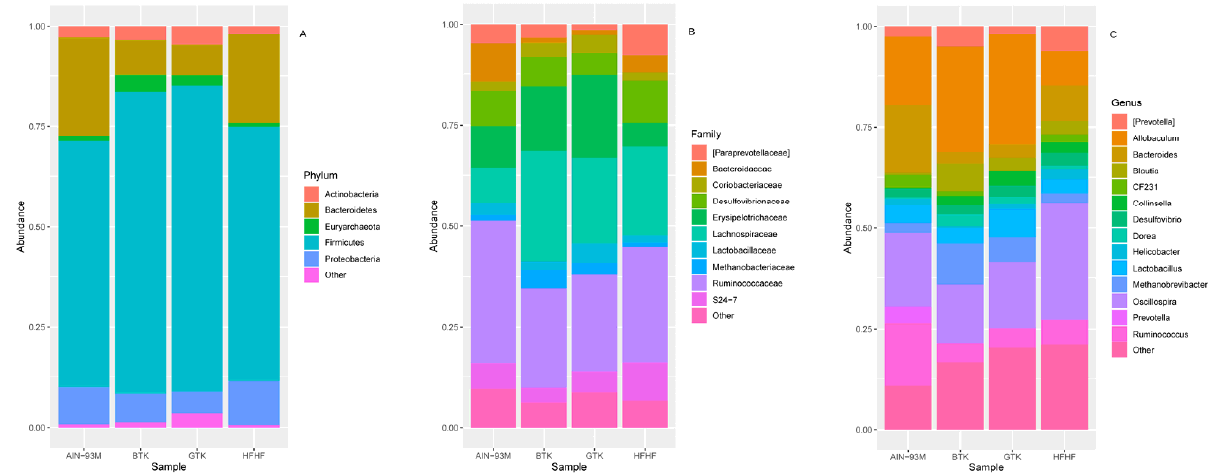
Figure 5. Stacked bar chart based on the relative abundance of major phyla (top-five) ( A ), families (top-ten) ( B ), and genera (top-fifteen) ( C ) across the groups AIN-93M, BTK, GTK, and HFHF. At the family level, 12 taxa (relative abundance greater than 1%) accounted for approx- imately 95% of the total sequences in each group. Among them, Ruminococcaceae was the most abundant family in the AIN-93M, GTK, and HFHF groups, whereas Lachnospiraceae was the most prevalent in the BTK group (Figure 5B). Although Lachnospiraceae was the most abundant in the BTK group and differed from the AIN-93M group ( p = 0.00049), this taxon appears as a biomarker of the HFHF group when compared to AIN93M (Figure 6A, LDA > 3, p = 00013). The third most abundant family among the groups, Erysipelotrichaceae , appears enriched in the groups that received both kombuchas (AIN-93M, 10.37%; BTK, 15.87%; GTK, 20.21%; HFHF, 5.74%) and was identified as a biomarker of the BTK group when compared to the group HFHF (Figure 6E LDA > 4; p = 0.0068). Interestingly,